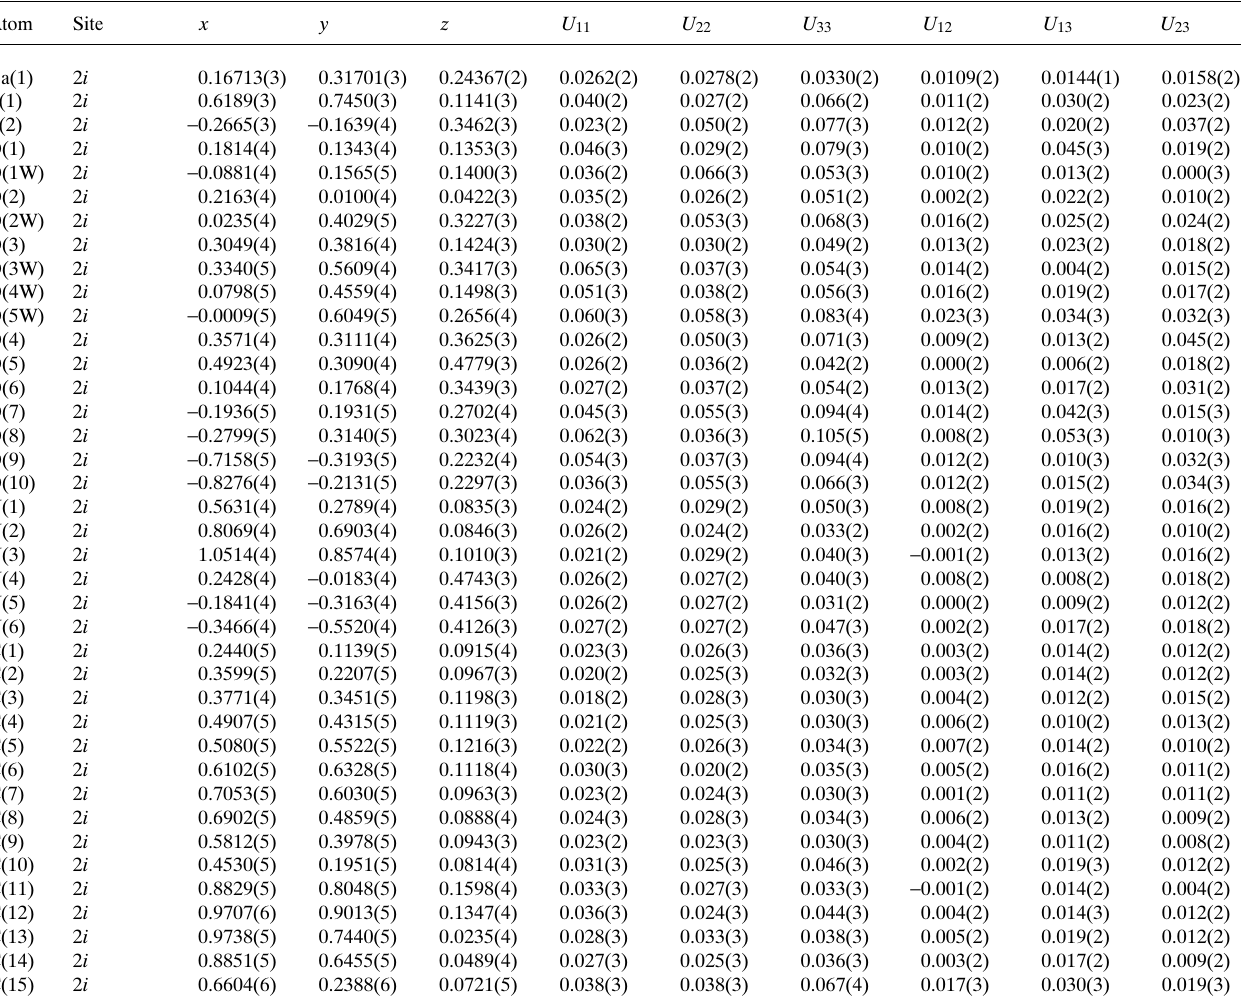
Table 3. Atomic coordinates and displacement parameters (in Å 2 ) .